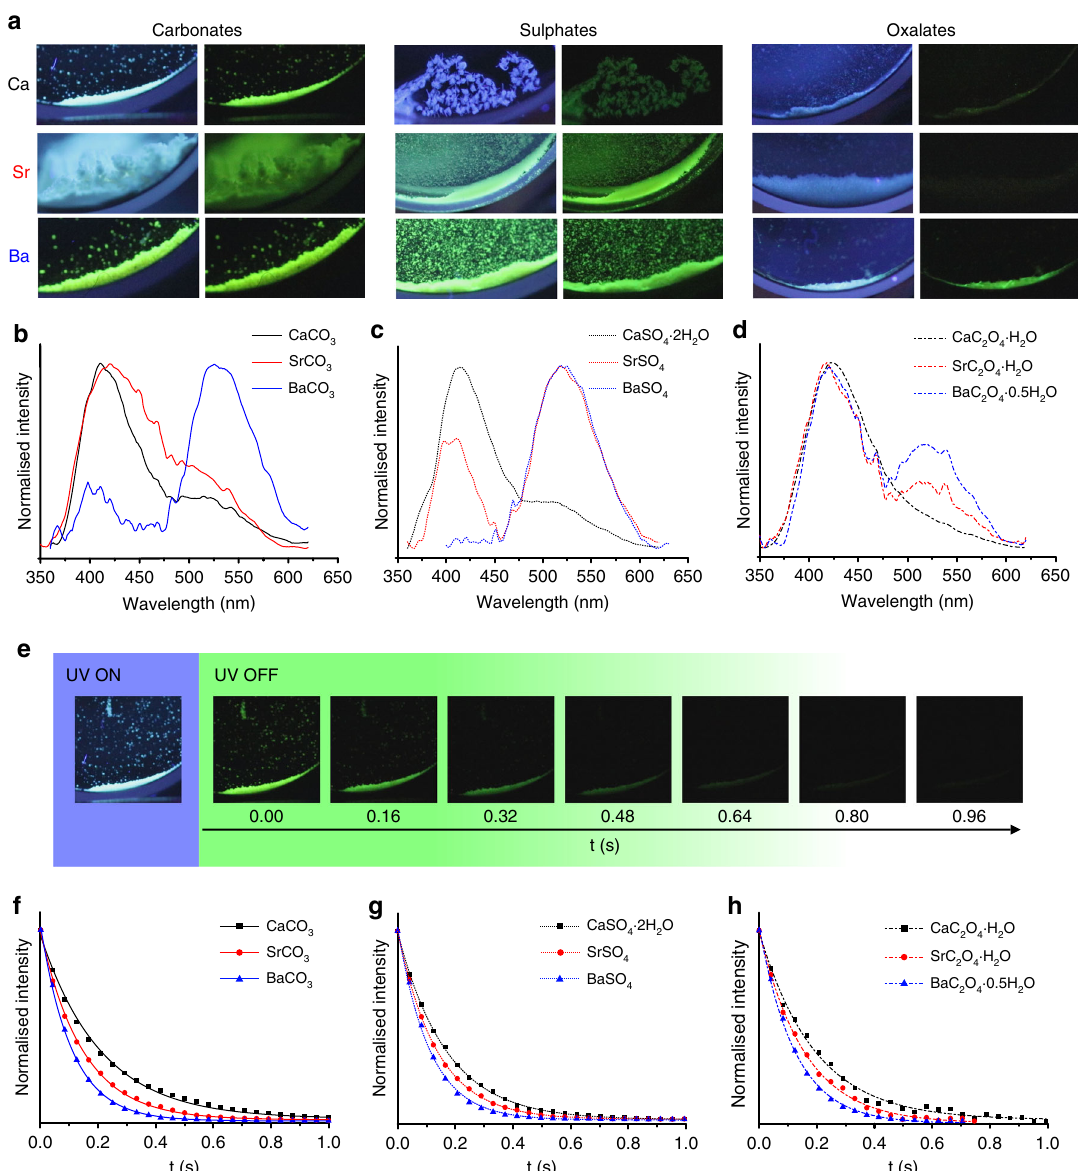
Fig. 2 Characterisation of the photoluminescent (PL) behaviour of folic acid-derived carbon nanodot (FF-CND)/host composites. Photographs of the nine F-CND/host nanocomposites with, and immediately after the removal of, UV (365 nm) excitation ( a ). Steady-state photoluminescence (SS-PL) emission spectra ( λ ex = 320 nm) of Ca (black) Sr (red) and Ba (blue) carbonates ( b , solid line), sulphates ( c , dotted line), and oxalates ( d , dashed line) F-CND/host nanocomposites. Images obtained during video stroboscopy experiments of afterglow from F-CND/CaCO 3 nanocomposite ( e ). UV ON: Nanocomposite under UV (365 nm) excitation showing steady-state luminescence. UV OFF: Photographs of the afterglow at different times (160 ms intervals) showing a decay in afterglow intensity with time. Decay curves obtained from video stroboscopy for Ca (black square), Sr (red circle), and Ba (blue triangle) carbonates ( f , solid line), sulphates ( g , dotted line), and oxalates ( h , dashed line) F-CND/host